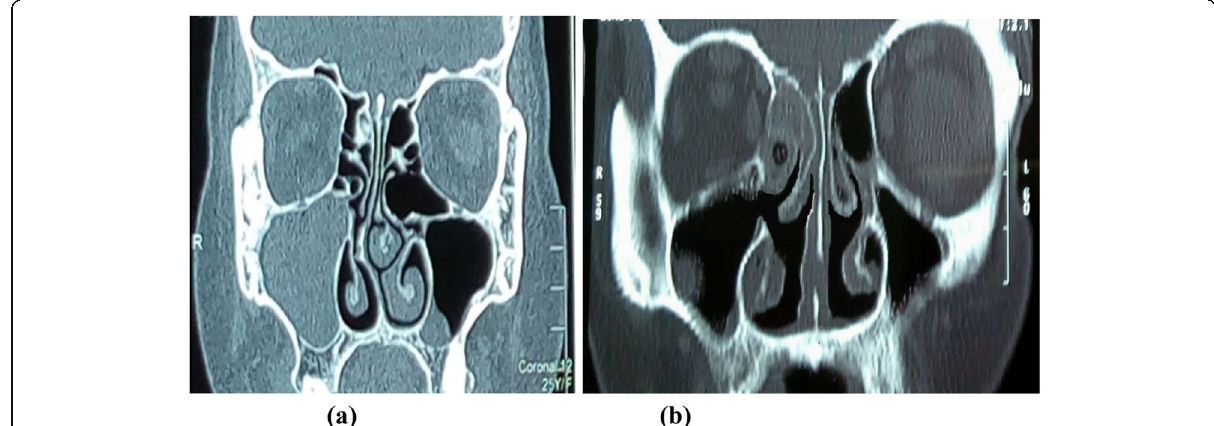
Fig. 2 CT of group B. a Pre-operative CT showing maxillary sinusitis. b Post-operative CT showing Rt ethmoid